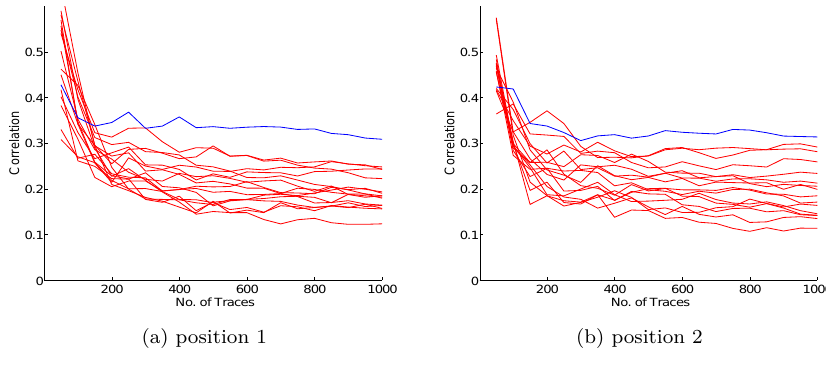
Figure 14: Basic CPA with HW